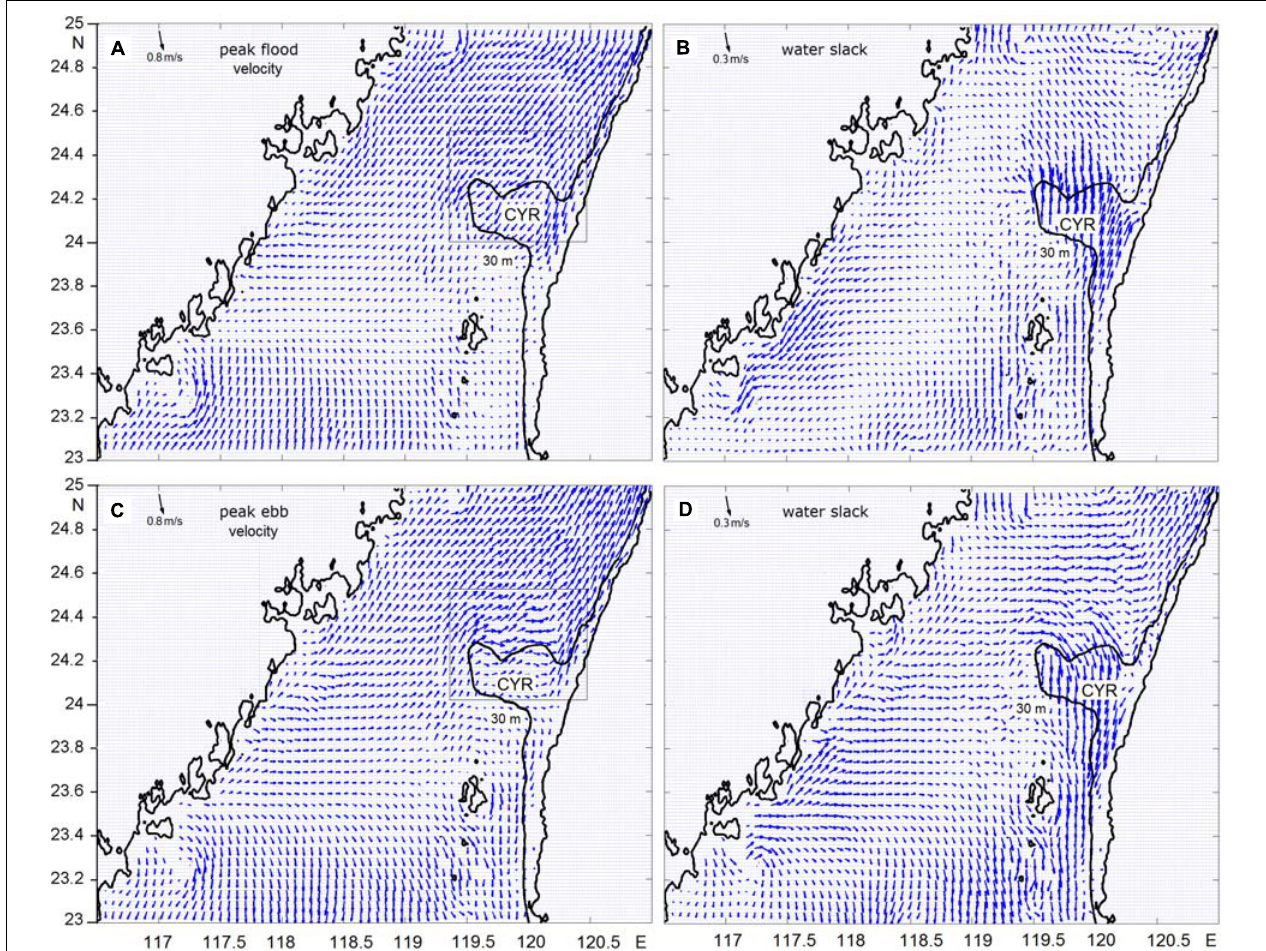
FIGURE 4 | Successive phases of planar distribution of the velocity at a depth of 10 m (below the surface) corresponding to the water elevations presented in Figure 3 . Figure shows (A) peak velocity on the flood, (B) velocity during the water slack after flood, (C) peak velocity on the ebb, and (D) velocity during the water slack after ebb. The black line delineates the 30 m